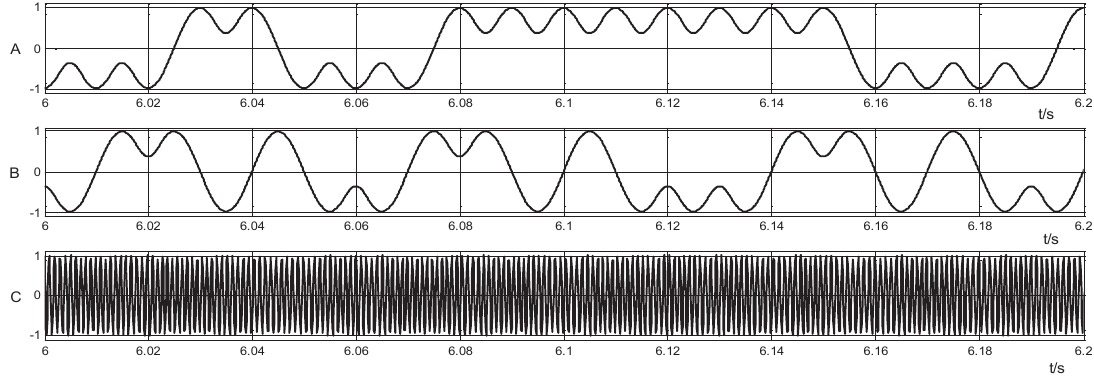
Figure 8. Simulation results of the partial-respond quadrature modulation. ( A ): The baseband symbol signal transmitted through the in-phase channel; ( B ): The baseband symbol signal transmitted via the orthogonal channel; ( C ): The quadrature-modulated output signal.